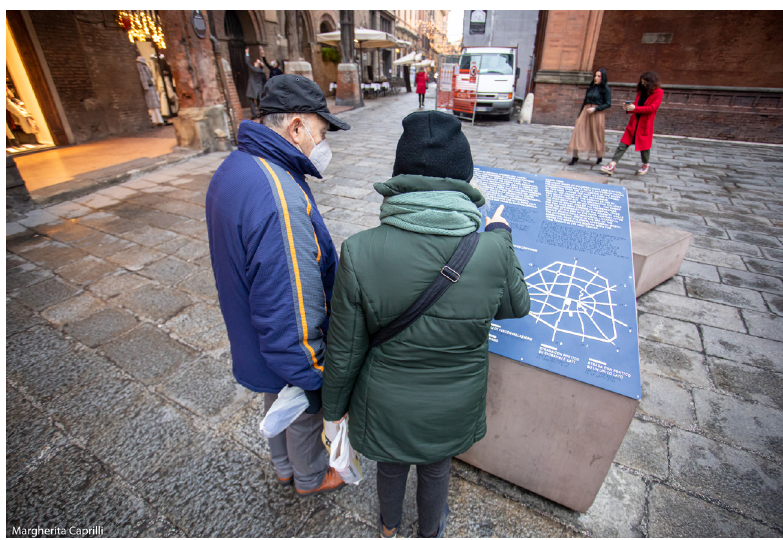
The installation of the monumental tactile map U-AREA FOR ALL - ROCK BOLOGNA project. Credits: Margherita